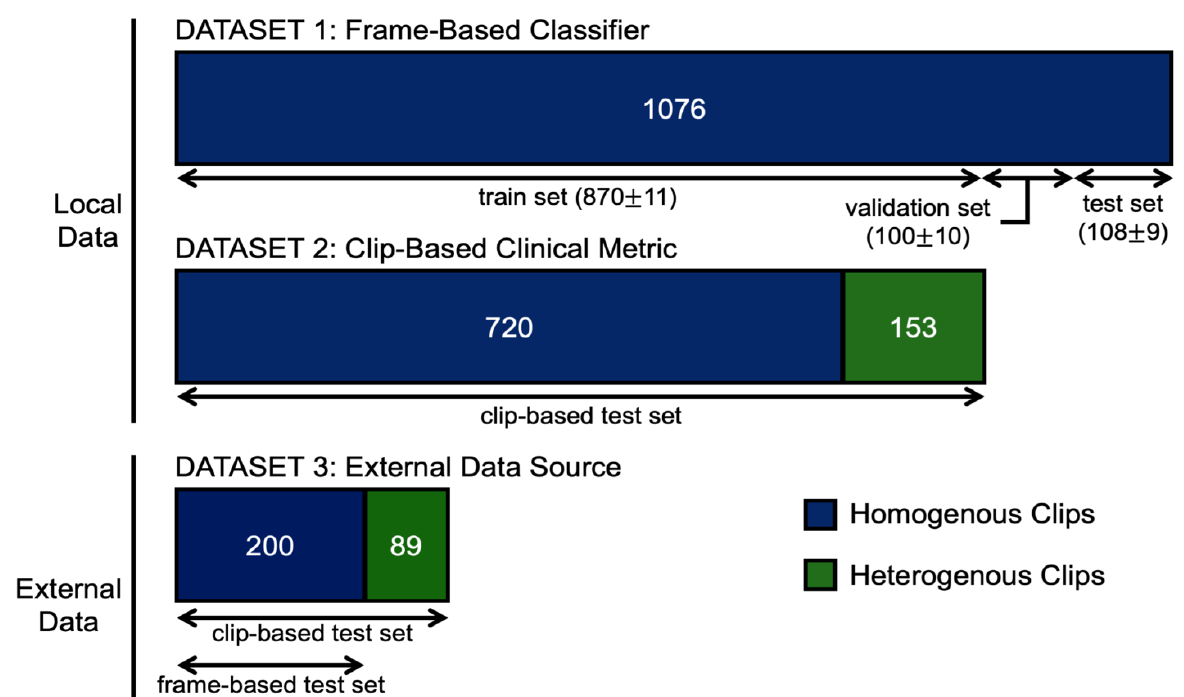
Figure 3. Schematic breakdown of the data sources, data volume, hetero/homogeneity, and how data were allocated in our frame-based classifier development and clip-based clinical metric. For the frame-based classifier, the number of clips used for the training, validation, and test sets are presented as the mean +/ − standard deviation of the ten-fold cross-validation partitions.